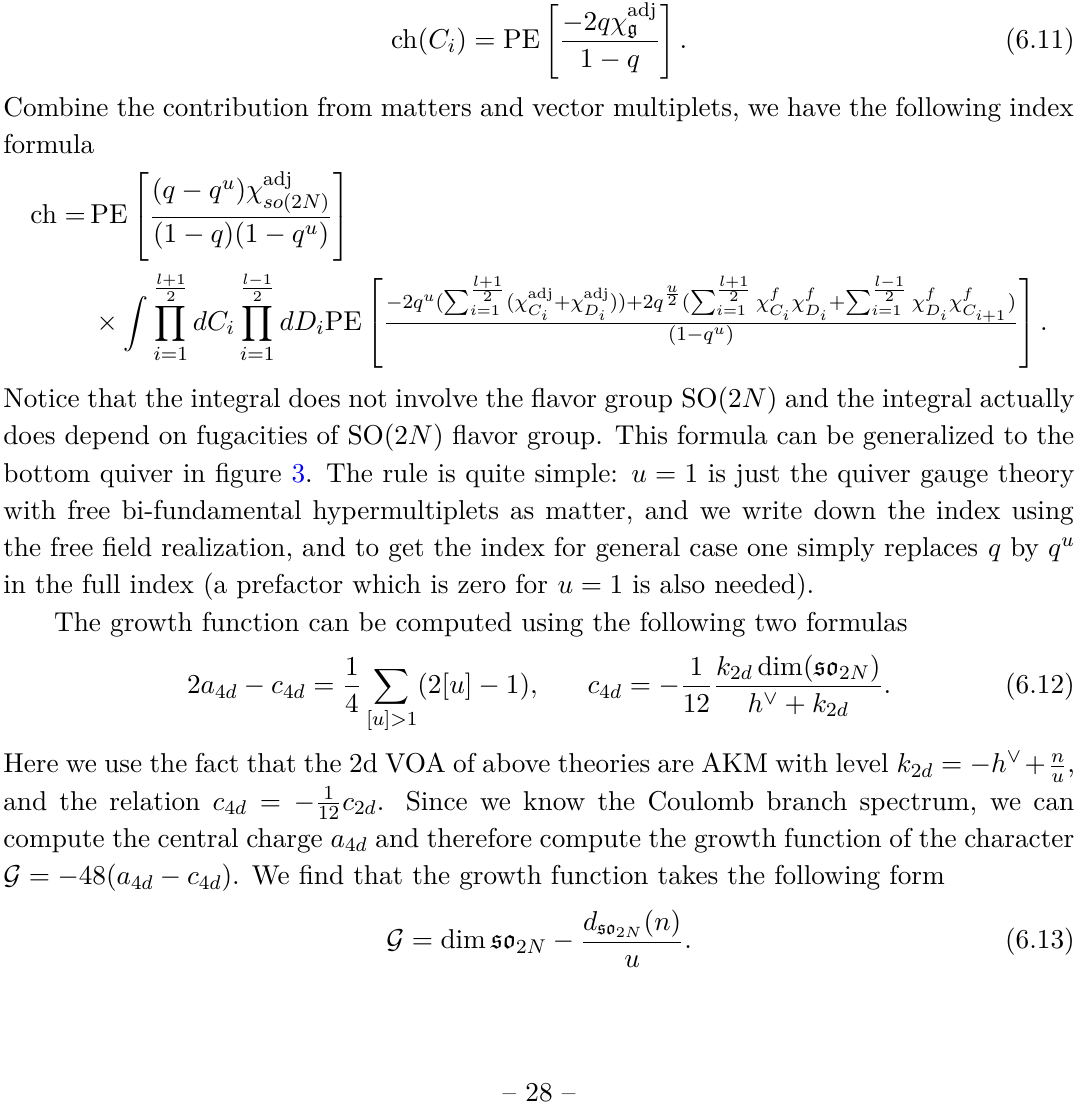
− 1 b) l = 2 N − 2 − 1 ; and u = n + k n n